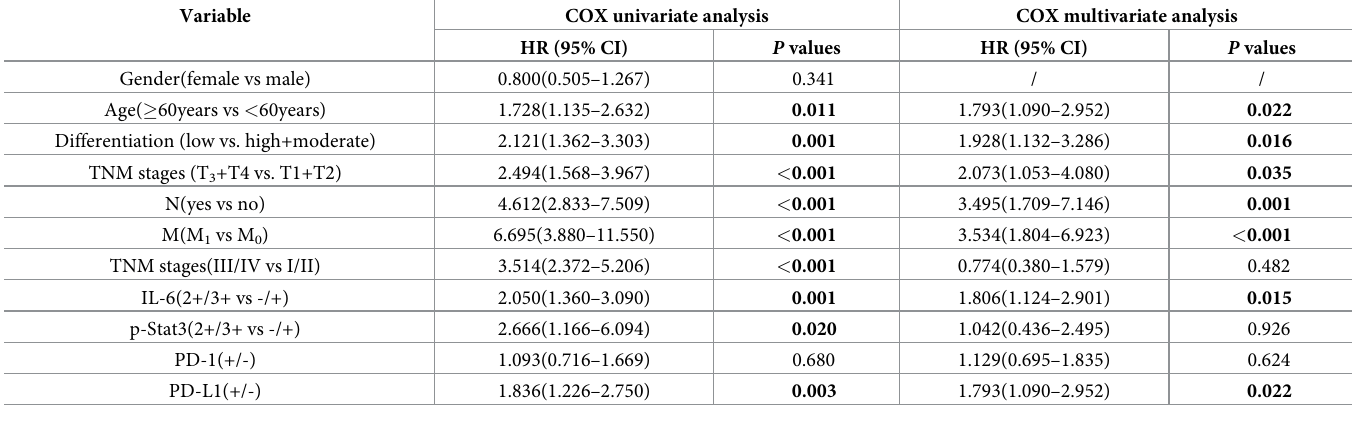
Table 3. Cox regression model analyses of bio-indicators in gastric